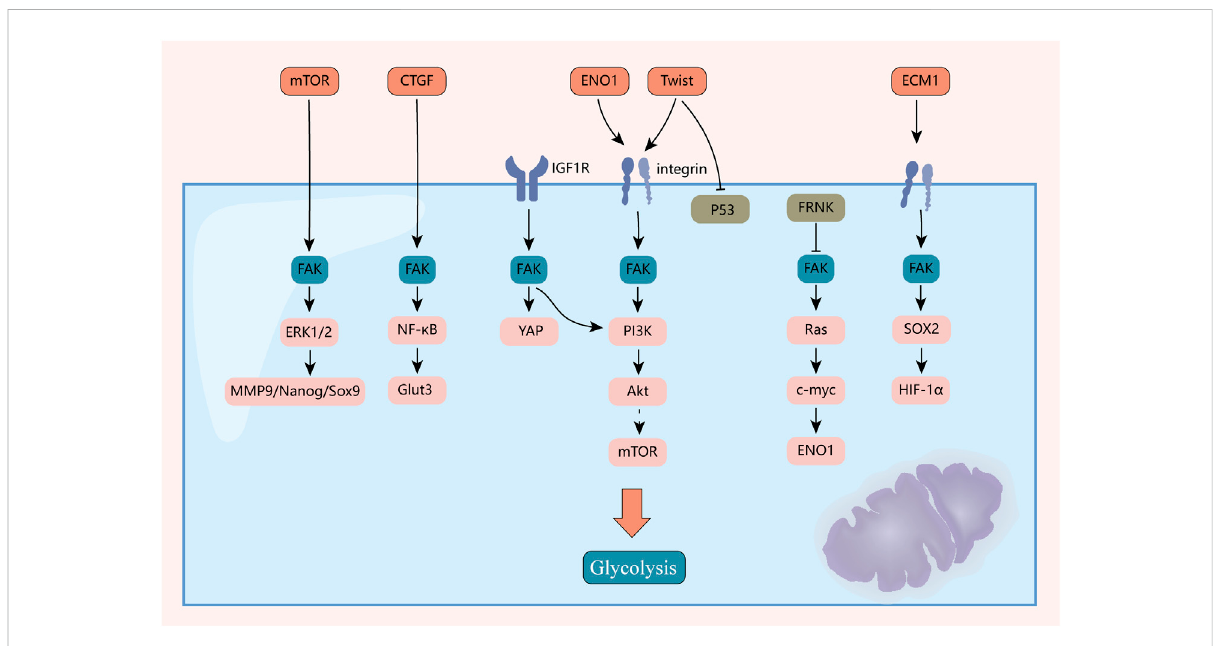
FIGURE 5 Mechanisms of FAK-mediated reprogramming of tumor glycolytic metabolism. FAK plays an important role in reprogramming the metabolism of the three major nutrients. This fi gure highlights the mechanisms by which it plays a role in reprogramming sugar